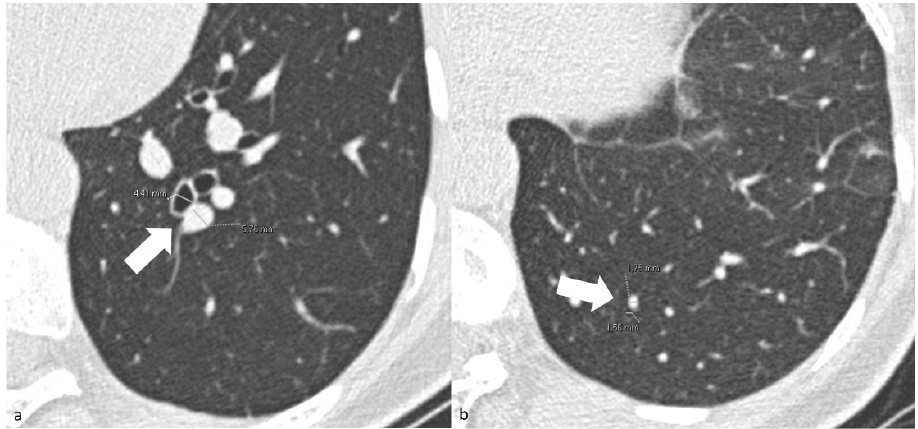
Figure 1. ( a ) Chest axial CT images of a COV-P patient. Measurements of the segmental arterial (4.41 mm) and adjacent bronchial branches (5.76 mm) (arrow). ( b ) Chest axial CT images of a COV-P patient. Measurements of the and subsegmental arterial (1.56 mm) and adjacent bronchial branches (1.75 mm) (arrow) of healthy lung parenchyma of the lower left lobe. To normalize the measures, the ratio between the caliber of each vessel and its